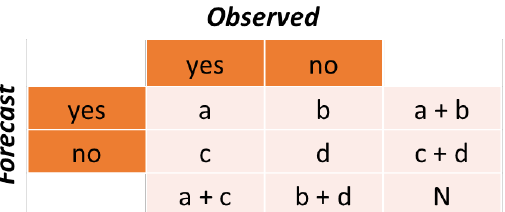
Figure 10. Contingency table schedule. The term a + b represents the forecasted meteorological events by the model. The term c + d represents the not forecasted meteorological events by the model. The term a + c represents the observed rainy weather events. The term a + d represents the non- observed rainy weather